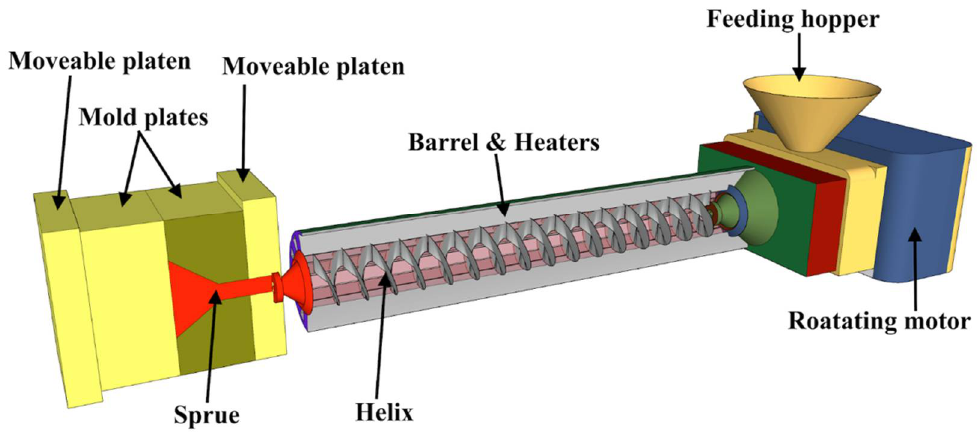
Figure 7. Schematic diagram of injection molding of polymers (redrawn from Ref. [225]).